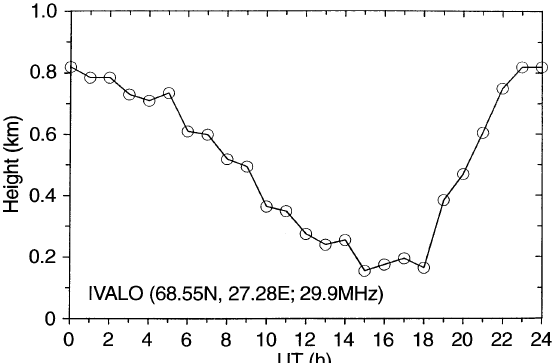
Fig. 12. Mean diurnal variation of cosmic noise absorption ob- served at the Finnish station Ivalo during July/August 1994 (from Ionospheric Absorption Data, Geophysical Observatory Sodankyla¨ )